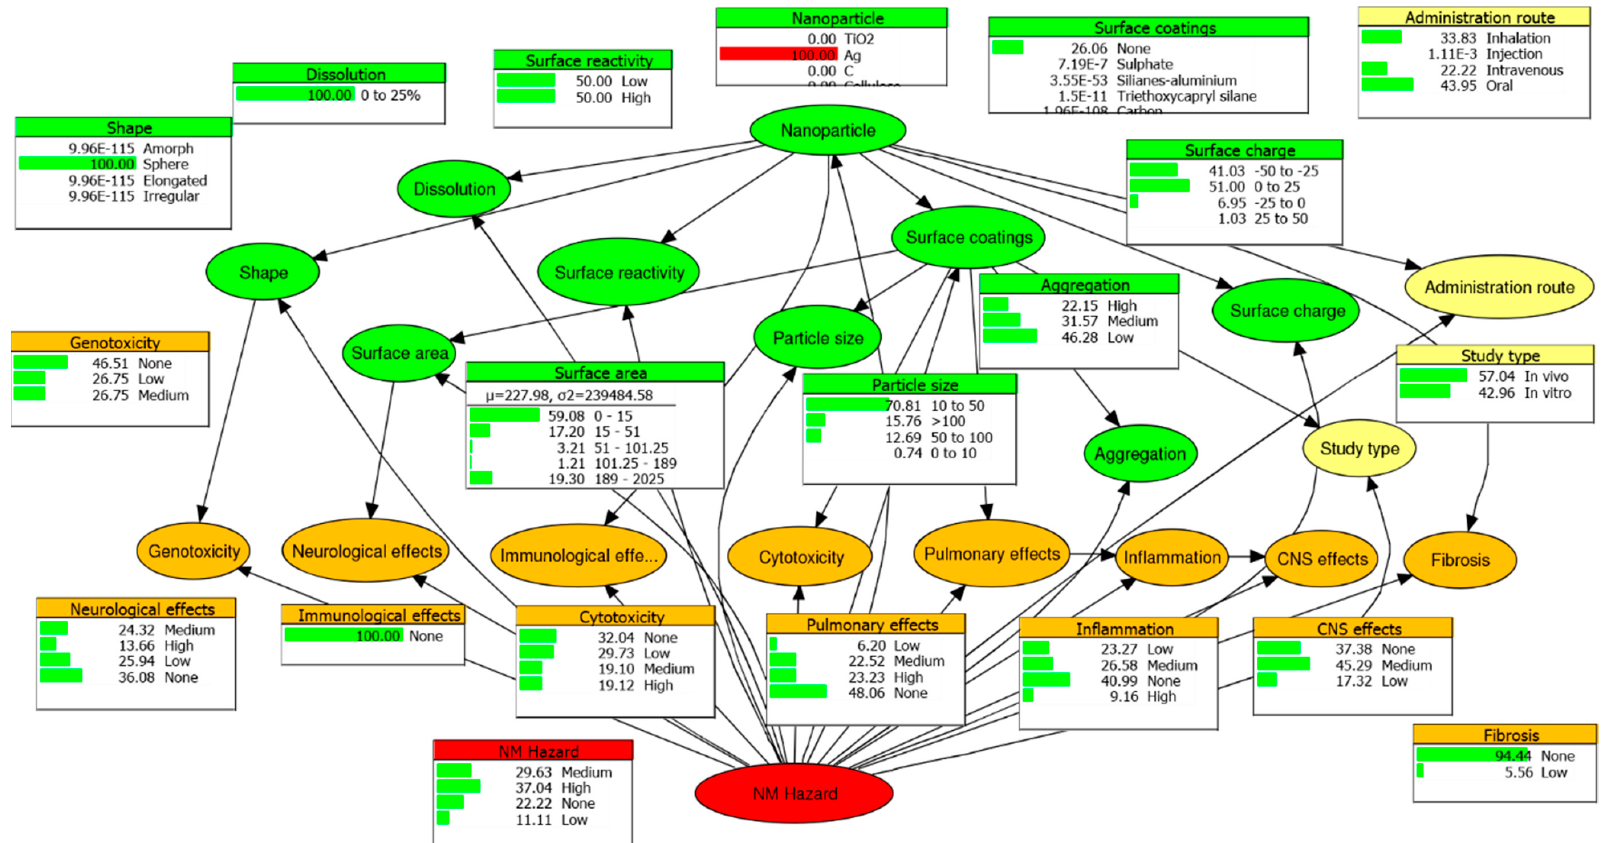
Figure A1. Graphical structure and parameterization of the BN with Ag input as evidence. Ellipses represent nodes and directed links signify the conditional relationship between parent and child nodes. The accompanying bar charts denote the % state probabilities. The nodes are colour categorised into green for physicochemical properties, yellow for study type, orange for biological effects, and red for NM hazard potential. Adapted from Marvin et al. [9].